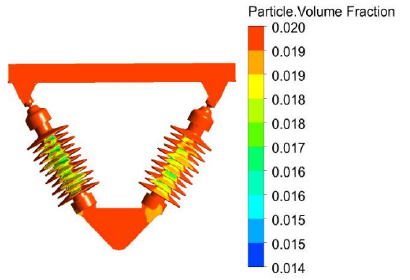
Figure 28. Distribution map of contamination on the front of insulators.